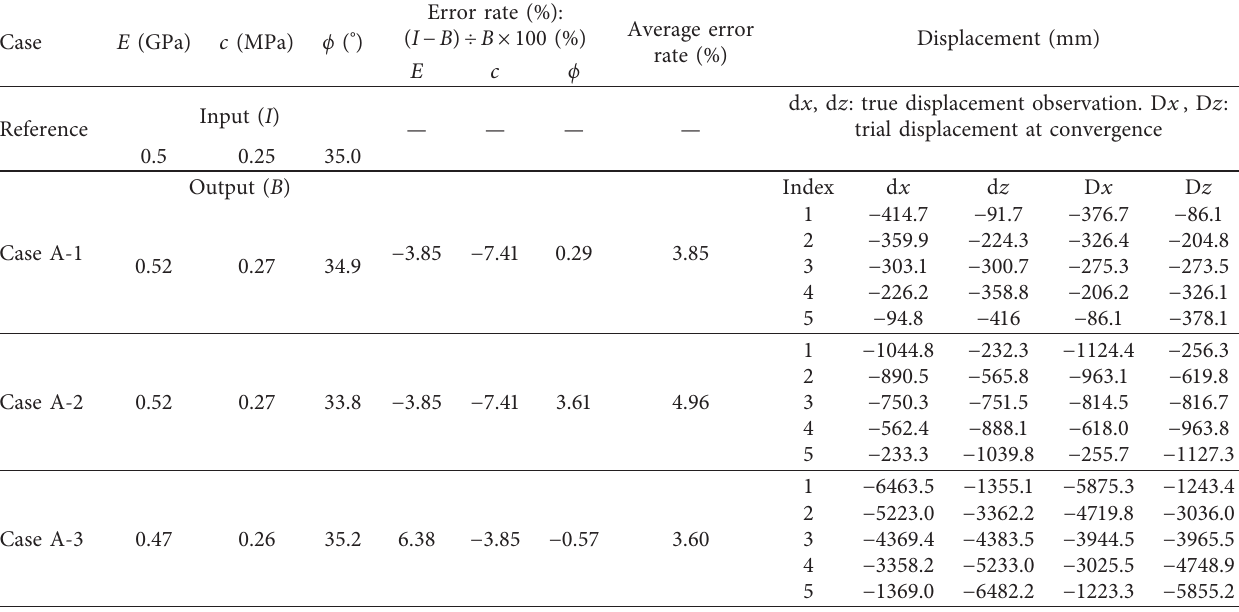
Table 4: Results of back analysis using the displacement induced by